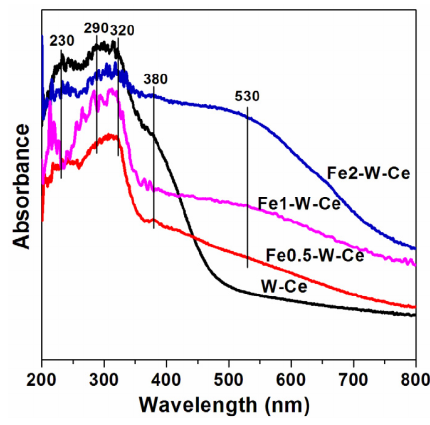
Figure 4. UV-vis of different catalysts. Figure 4. UV ‐ vis of different catalysts.